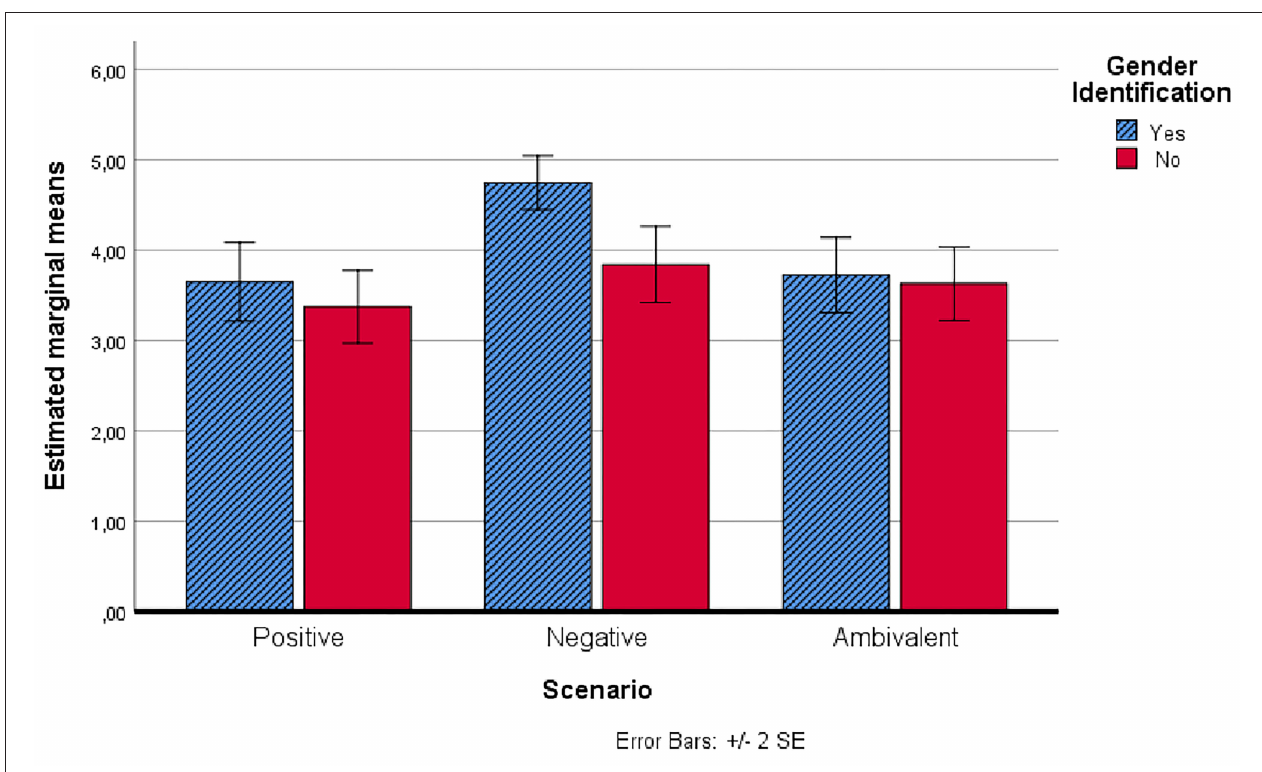
FIGURE 2 | Estimated marginal means of the intention to carry out a diagnostic test for hepatitis C after the administration of scenarios.